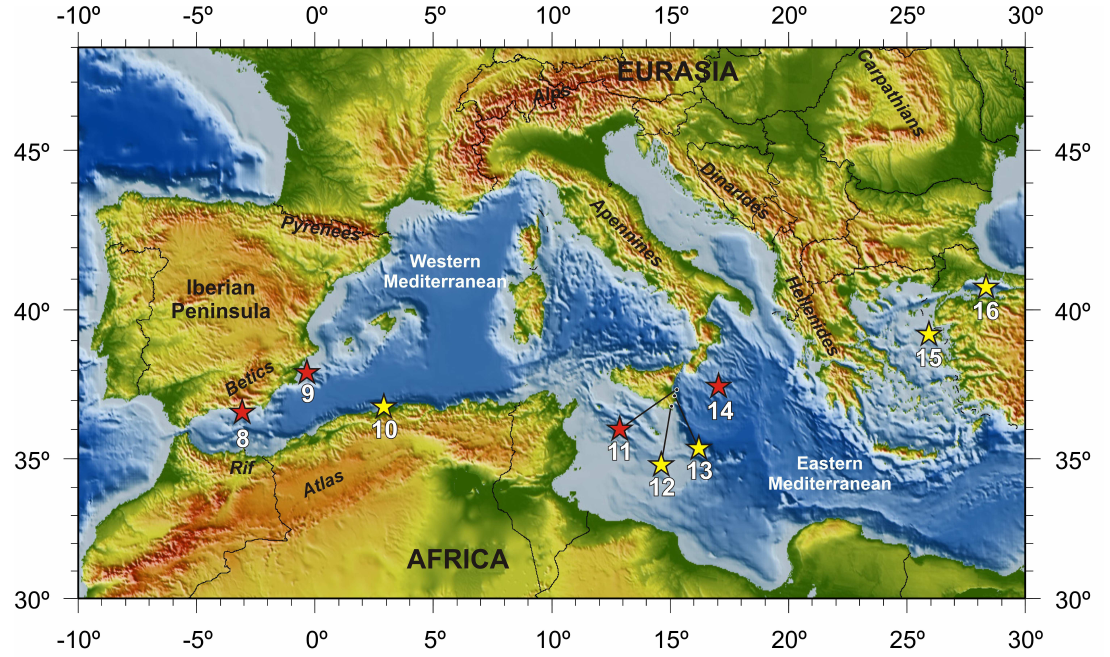
Fig. 2. Topographic and bathymetric map of the Mediterranean Sea with the location of areas studied in the articles of this Special Issue. Red stars correspond to on-fault paleoseismic studies and yellow stars to off-fault paleoseismic studies. (8) Adra Fault, NE Alboran Sea (Gràcia et al., 2012); (9) Bajo Segura Fault, western Mediterranean (Perea et al., 2012); (10) Central Algerian Margin (Cattaneo et al., 2012); (11) eastern Sicily (Argnani et al., 2012); (12) Pantano Morghella, SE Sicily (Gerardi et al., 2012); (13) Augusta Bay, eastern Sicily (Smedile et al., 2012); (14) Ionian Sea (Polonia et al., 2012); (15) Lesvos Island, NE Aegean Sea (Vacchi et al., 2012); (16) Marmara Sea (Drab et al., 2012). Main plates and mountain ranges are